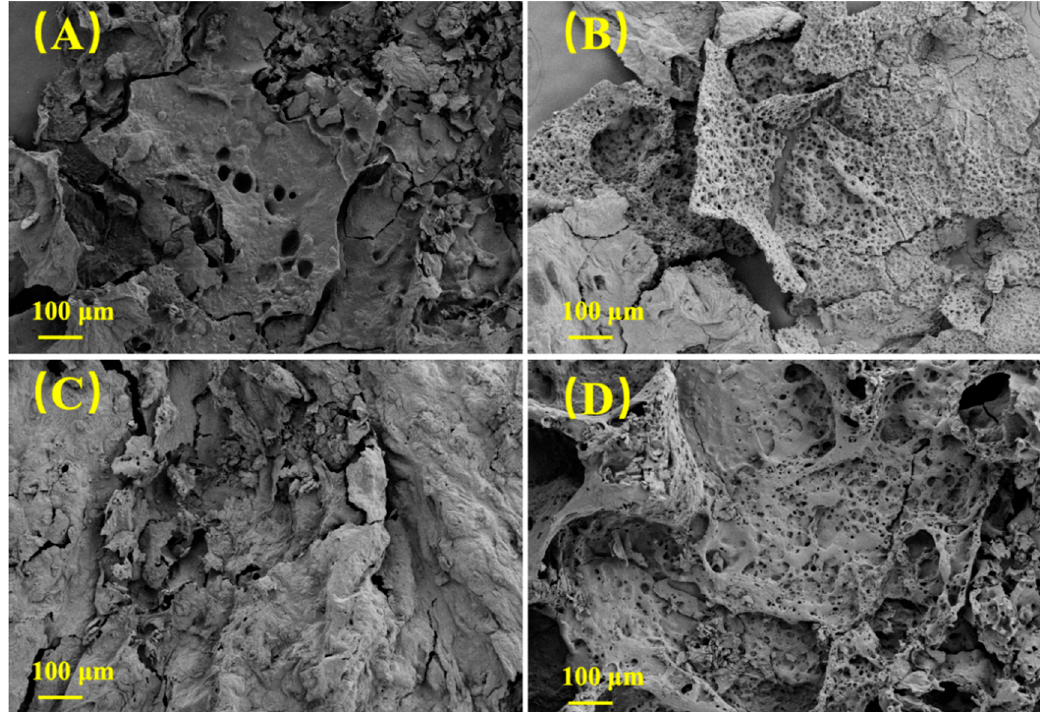
Figure 7. SEM of char residue of PVA and MXene/PVA nanocomposites after cone calorimeter test: ( A ) PVA; ( B ) MXene 1 . 0% /PVA; ( C ) PVA-PVPA 10% -PEPA 5% ; and ( D ) MXene 1 . 0% /PVA-PVPA 10% - PEPA 5% .